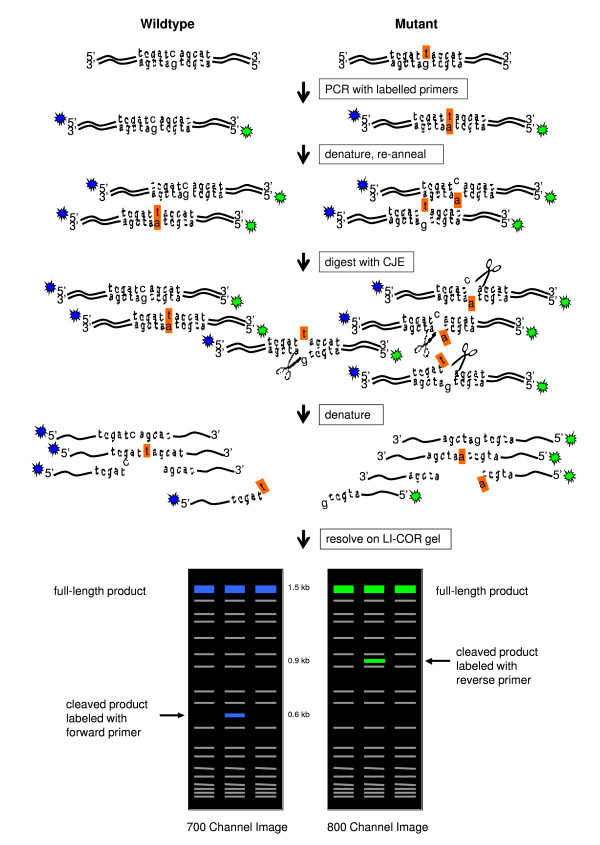
Overview of the TILLING procedure. Pooled DNA is amplified using fluorescently tagged, gene-specific primers. The forward and reverse primers are labelled with different fluorophors that label both ends of the fragment. The amplified products are denatured by heating and then allowed to cool slowly so that they randomly re-anneal. Heteroduplex molecules form when mutant and wild-type PCR products anneal together, and these then become targets for a single-strand-specific nuclease found in Celery Juice Extract (CJE). The nuclease cleaves these heteroduplex fragments at one of the two strands, 3' to the site of the mismatch in the DNA. The PCR products that retain one of the labelled primers can then be detected on polyacrylamide denaturing LI-COR gels. Individuals with a mutation in the gene of interest are identified by the smaller cleavage fragment seen on the gel as well as the wild-type product. Because the nuclease cleaves either of the two strands randomly, cleavage products can be detected in both the IRD700 and IRD800 channels of the gel image. The position of the mutation within the PCR amplicon can be calculated from the size of the two fragments carrying the forward, IRD700-labeled primer, and the reverse, IRD800-labeled primer. Grey bands on the gel are thought to result from partial PCR products and aid in sizing of mutant bands.